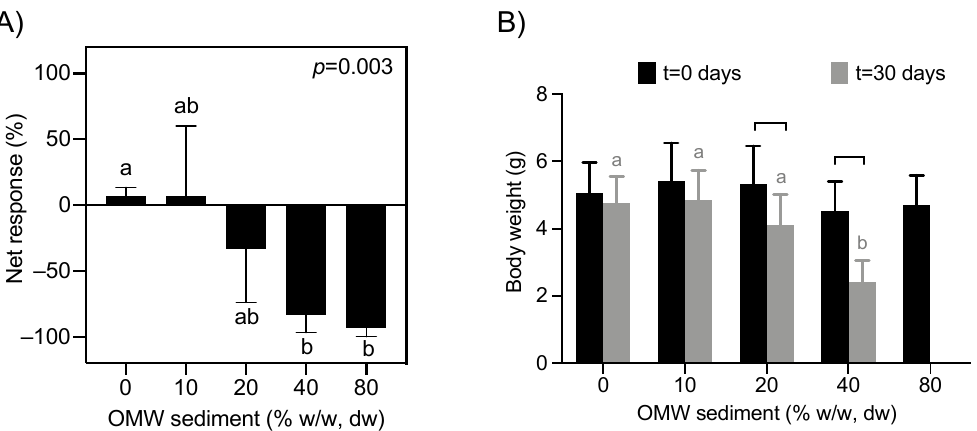
Figure 2. ( A ) Avoidance behaviour response of Lumbricus terrestris to olive mill waste (OMW)-amended soils. Statistical di ff erences between treatments indicated by di ff erent letters ( p < 0.05, Games–Howell post-hoc test). ( B ) Mean body weight of earthworms exposed for 30 d to OMW-amended soils. Di ff erent letters indicate significant di ff erences between treatments within a sampling time ( p < 0.05), whereas asterisks denote di ff erences between sampling times ( p <